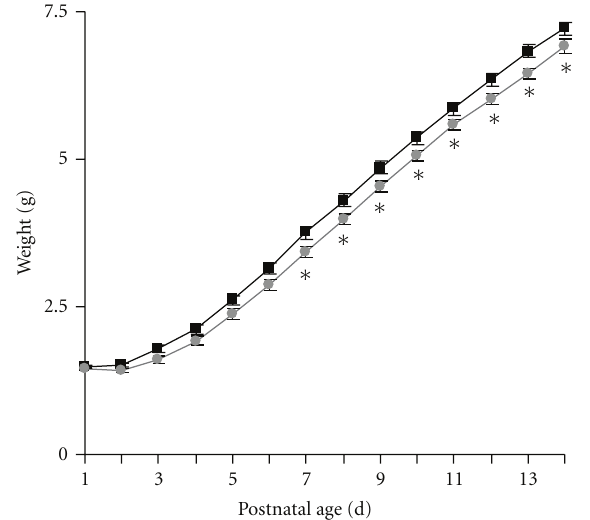
Figure 1: Neonatal SSRI exposure acutely decreased pup growth. Pups were weighed immediately prior to daily administration of 10mL/kg saline (white symbols) or 5mg/kg sertraline (gray symbols) from P1 to P14. N = 34 control and 40 SSRI-exposed pups. ∗ P < 0 . 05 by two way repeated measures ANOVA with Holm- Sidak method for multiple pair-wise